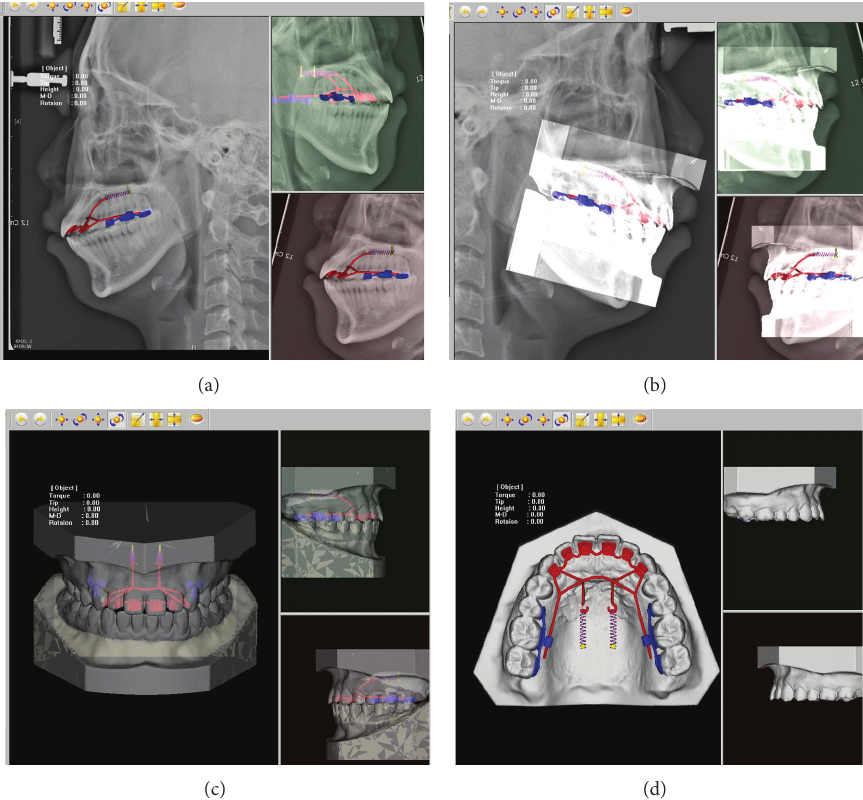
Figure 3: Preliminary design in the 3Txer software. (a) Lever arm length was designed considering center of resistance (Cres) of the 6 anterior teeth on the lateral cephalogram. (b) Registration of 3D model and lateral cephalogram. (c) Appliance design on the frontal view. (d) Occlusal